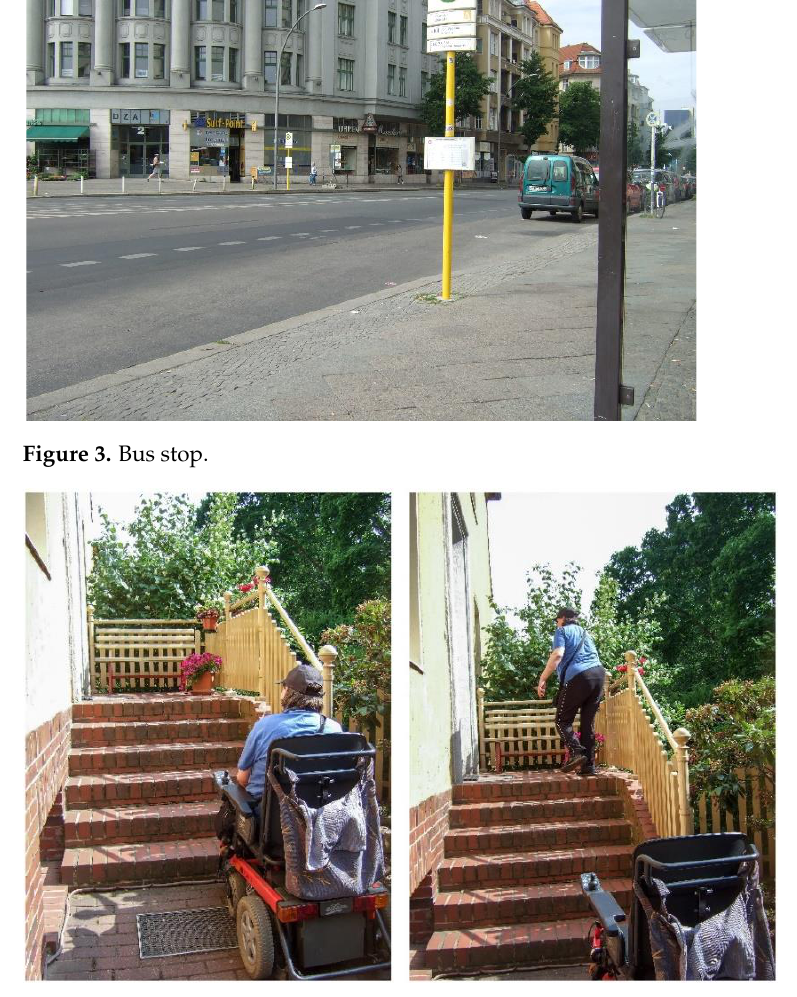
Figure 4. Medical